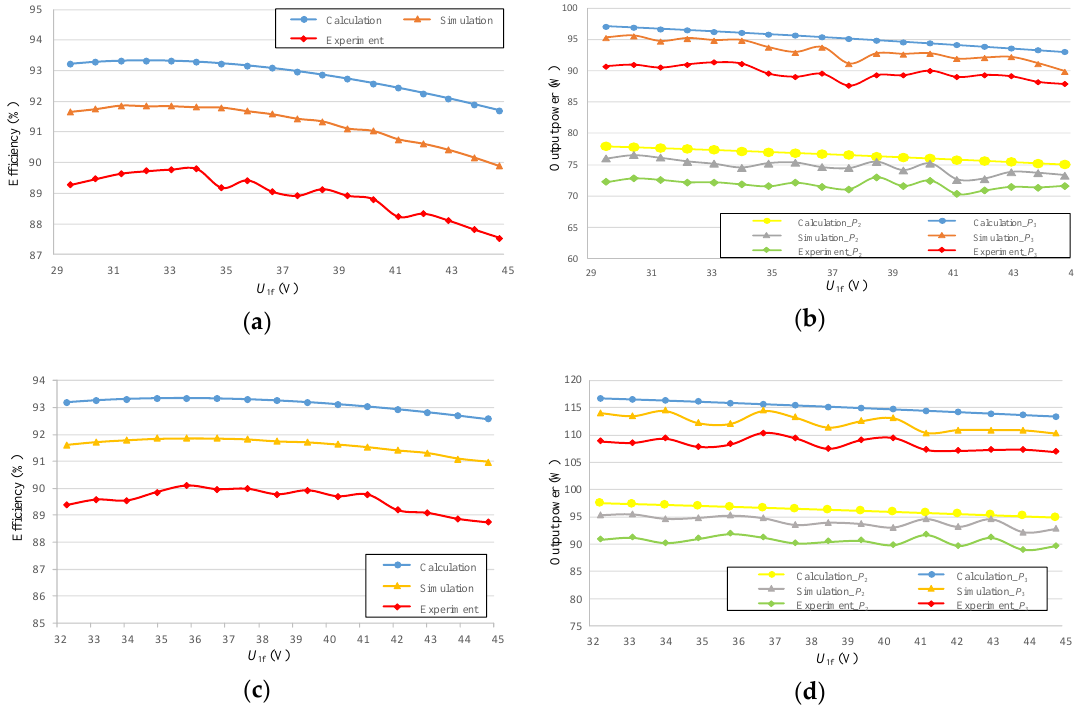
Figure 13. Result comparison: ( a ) efficiency levels of mathematical model, simulation model, and experimental prototype for target power levels of 80 and 100 W; ( b ) output power levels of the mathematical model, simulation model, and experimental prototype for target power levels of 80 and 100 W; ( c ) efficiency levels of the mathematical model, simulation model, and experimental prototype for target power levels of 100 and 120 W; ( d ) output power levels of the mathematical model, simulation model, and experimental prototype for target power levels of 100 and 120 W.